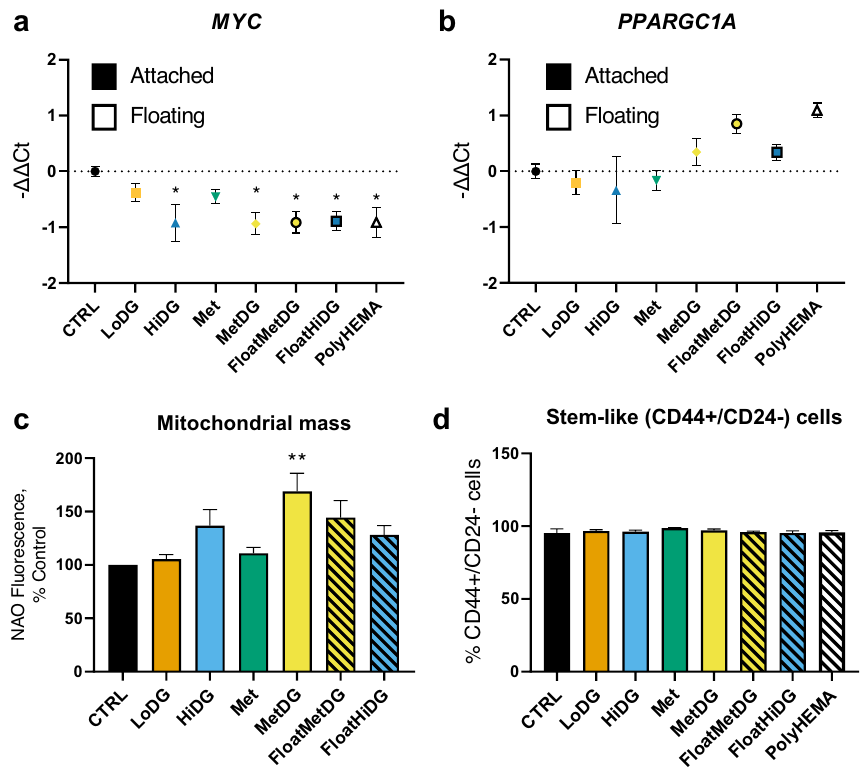
Figure 7. Expression of transcription factors MYC ( a ) and PGC-1α ( b ), mitochondrial mass ( c ) and breast cancer stem cell markers CD44/CD24 ( d ) . MDA-MB-231 cells were treated for 48 h ( a – c ) or 72 h ( d ), after which cells were collected and RNA was isolated and quantitative real time PCR performed ( a, b ). Mitochondrial mass was determined with flow cytometry using nonyl acridine orange (NAO) staining, ( c ) stem cell markers CD44 and CD24 were measure by flow cytometry ( d ). The mean − ΔΔCt ± SEM is shown for 4 independent experiments ( a, b ) and the mean NAO fluorescence per cell ± SEM ( c ) or percentage of CD44+/ CD24− cells ± SEM ( d ) is shown for 3 independent experiments. ** p < 0.01 as determined by